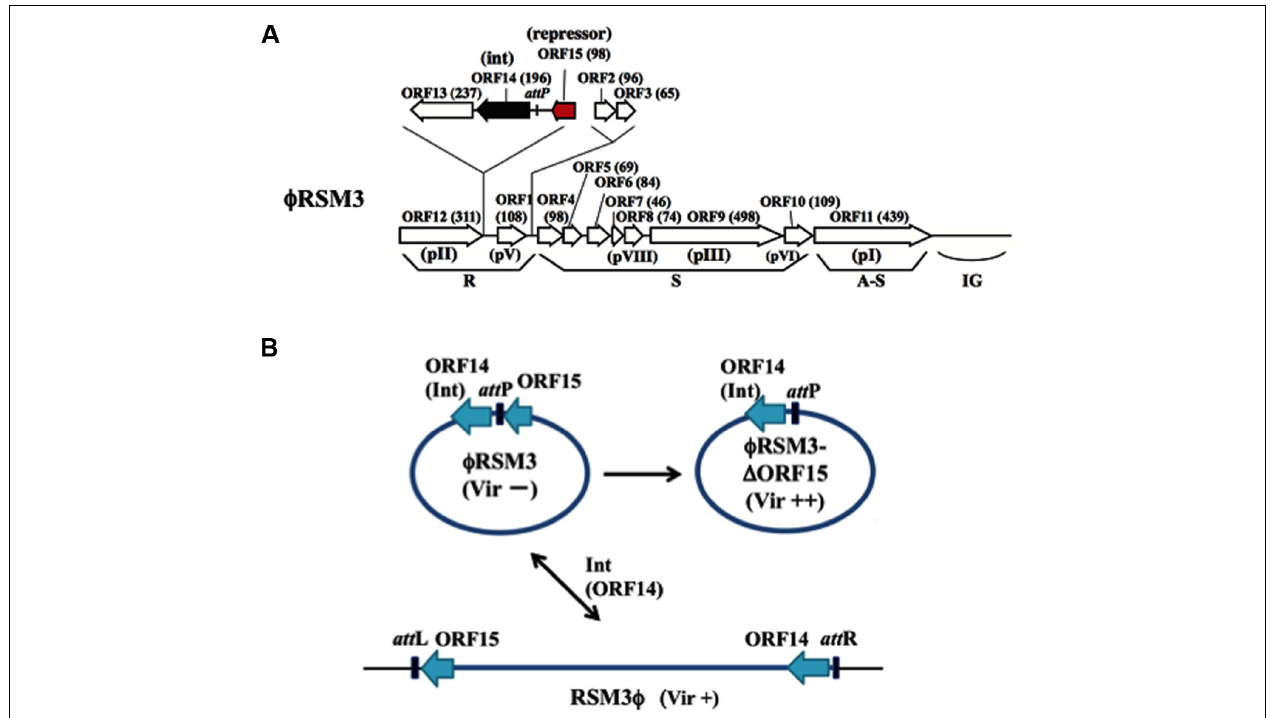
FIGURE 2 | φ RSM type filamentous phages infecting R. solanacearum. (A) Genomic organization of φ RSM1 (Kawasaki etal., 2007; Askora etal., 2011). Map is drawn in the same way as in Figure 1 . ORF14 and ORF15 correspond to Int (resolvase/invertase-like serine recombinase) and a newly identified DNA-binding repressor-like protein (Addy etal., 2012a), respectively. att P corresponds to a 13-nt 3’-end of the serine tRNA(UCG). (B) Interrelationship between three states of φ RSM phages. For the experimental convenience φ RSM3 was used in the study.The phage genomic DNA is shown in a circular form where most genes are not shown. φ RSM3- Δ ORF15